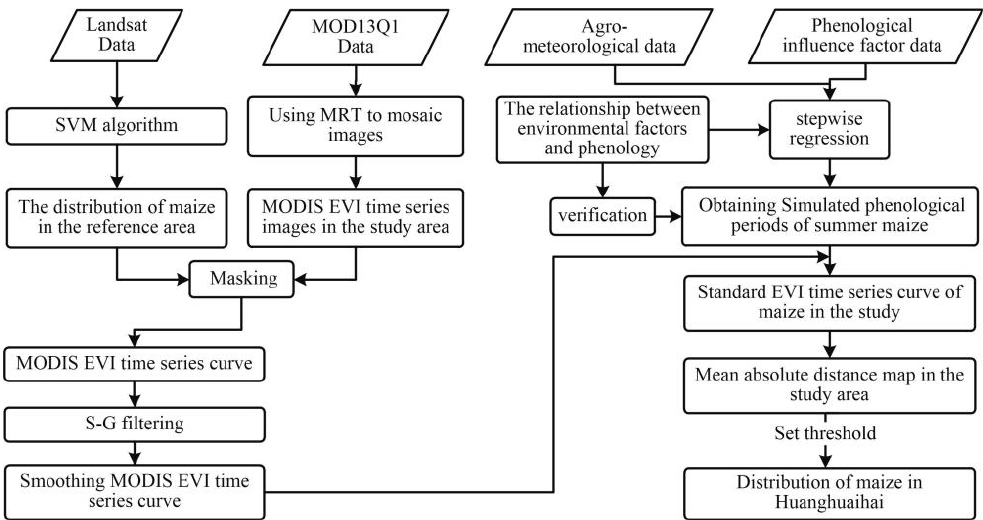
Figure 3. The flowchart to map the summer maize cultivated area over Huanghuaihai Plain.